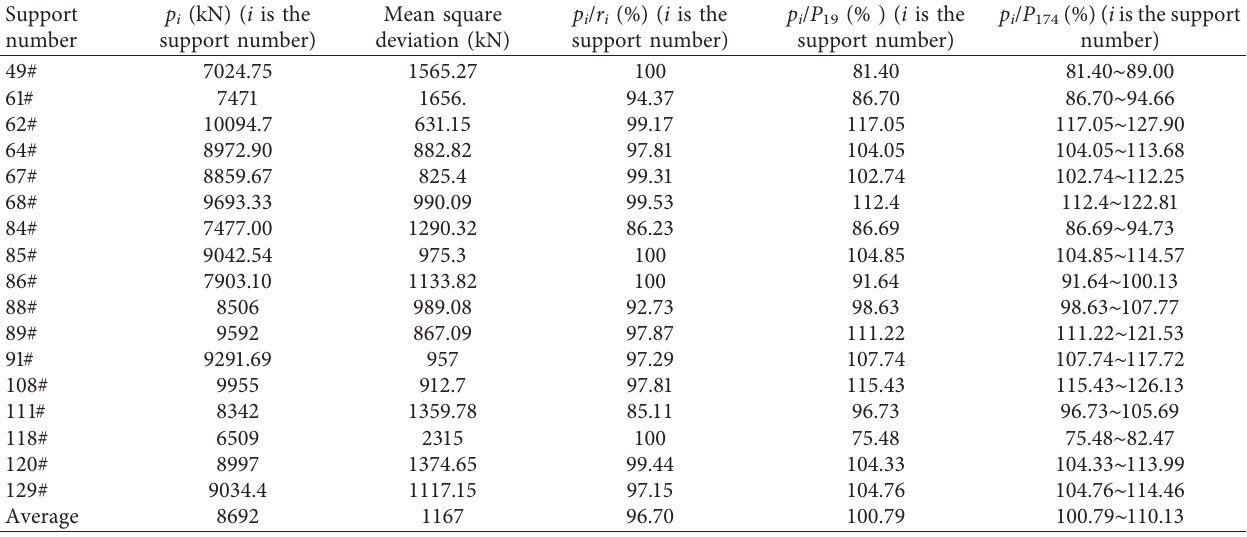
Table 2: The overrun rate of supports working resistance during periodic